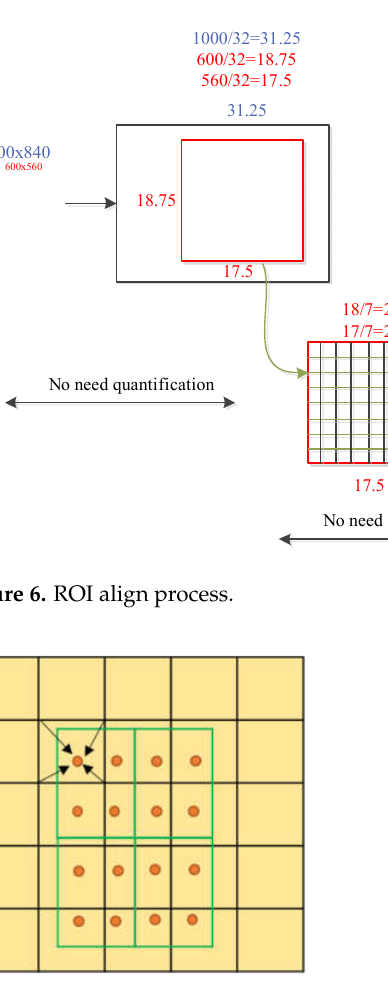
Figure 5. Schematic diagram of ROI Pooling.